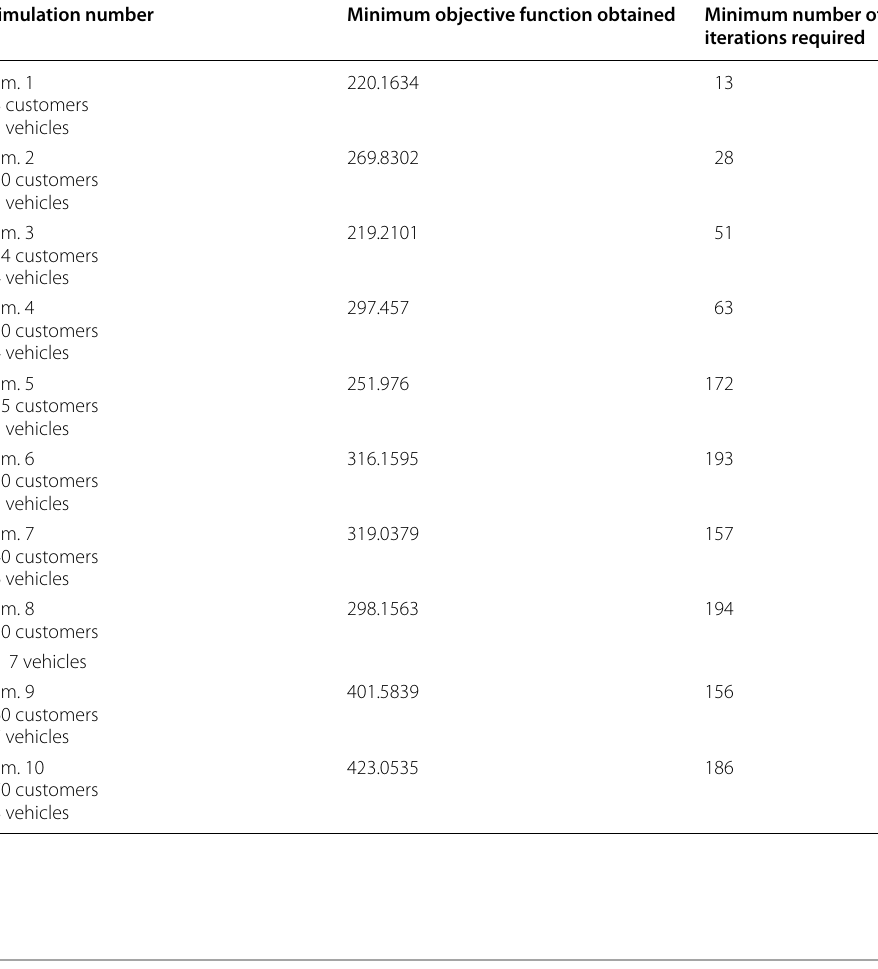
Table 2 Results obtained by HHO for VRP